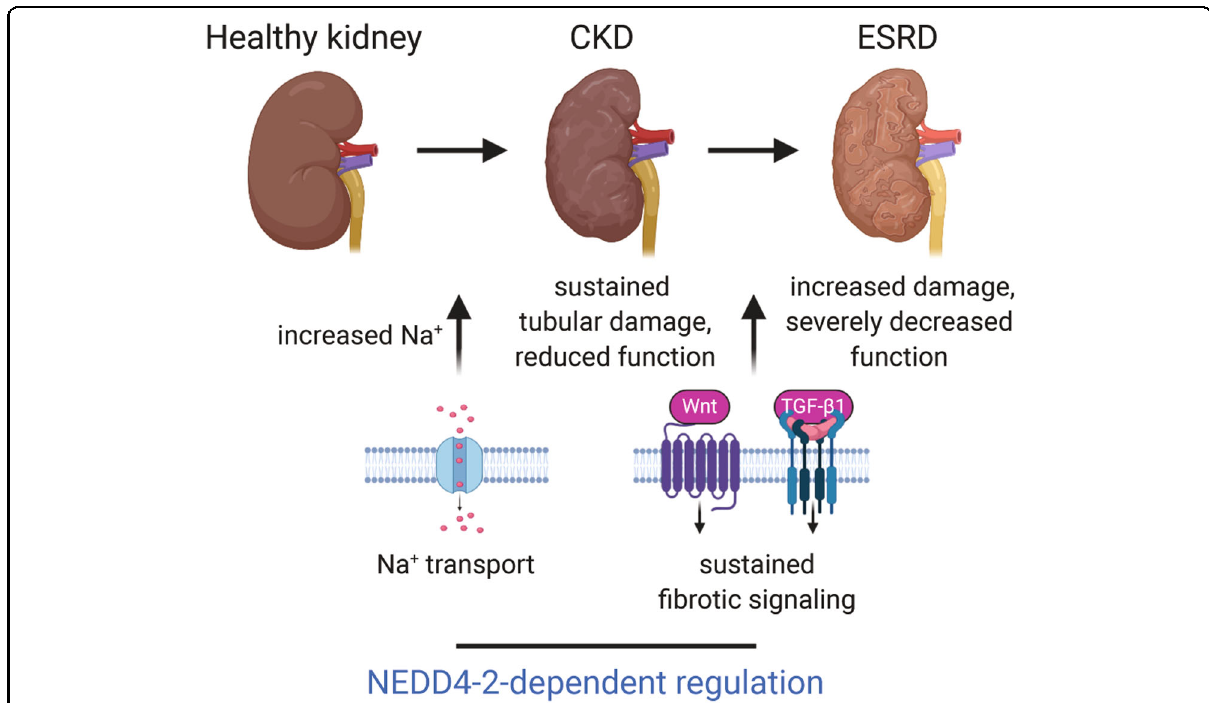
Fig. 8 A model of NEDD4-2-dependent control of kidney disease progression. NEDD4-2 regulates several molecular processes that contribute to the progression of kidney disease, including Na + transport and fi brotic signaling pathways. This occurs through ubiquitination of substrates such as ENaC (and other channels and transporters) as well as downstream components of Wnt/ β -catenin/TGF- β 1 signaling pathways. In the absence of NEDD4-2, increased Na + contributes to sustained tubular damage with a mild reduction in kidney function. Sustained signaling through Wnt and TGF- β 1 pathways, particularly as a result of high dietary Na + , drives increased kidney damage and severely decreased renal function suggesting progression from CKD to ESRD. Figure created with